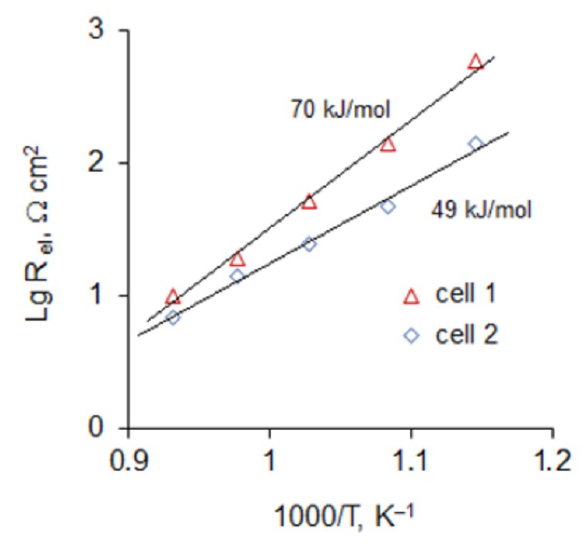
Figure 8. Arrhenius plots of the electrode resistance of cells 1 and 2.